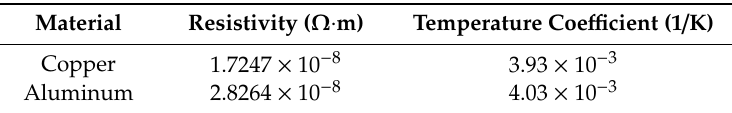
Table 2. Resistivity and temperature coefficient.